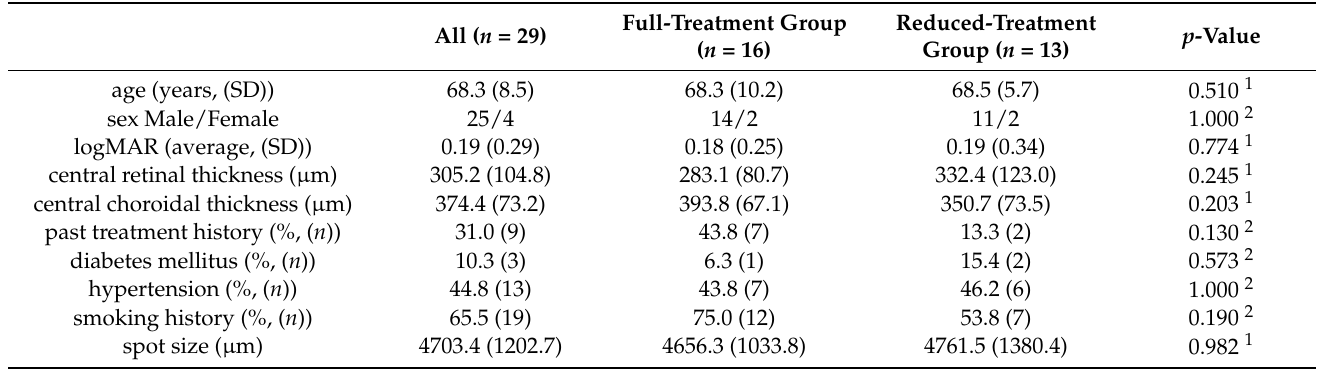
Table 1. Clinical characteristics of patients at baseline.